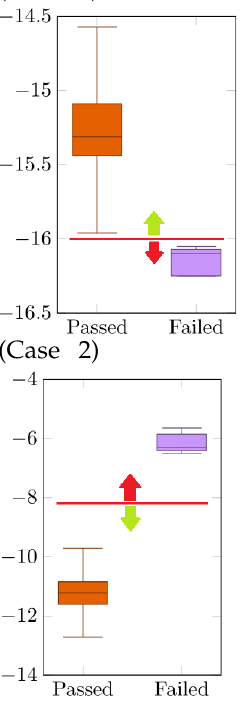
Figure 3. Determining threshold